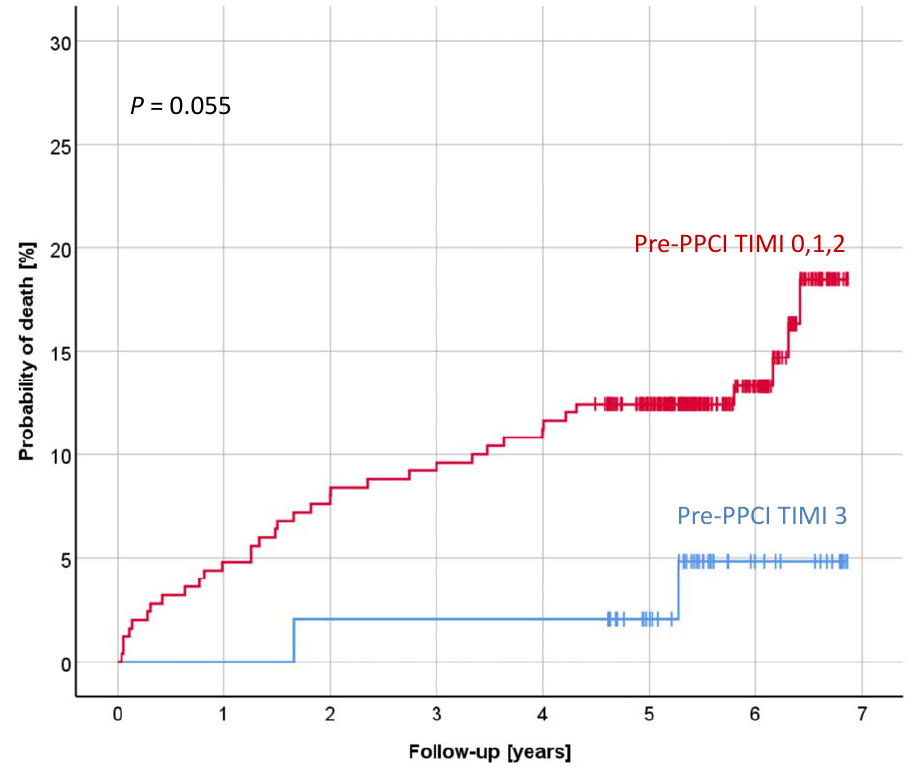
Fig. 2. Kaplan-Meier analysis of probabilities of death in patients with a pre-PPCI TIMI flow grade 0, 1, and 2 (red line) and those with pre-PPCI TIMI flow grade 3 (blue line). Crosses of the survival curves indicate censored